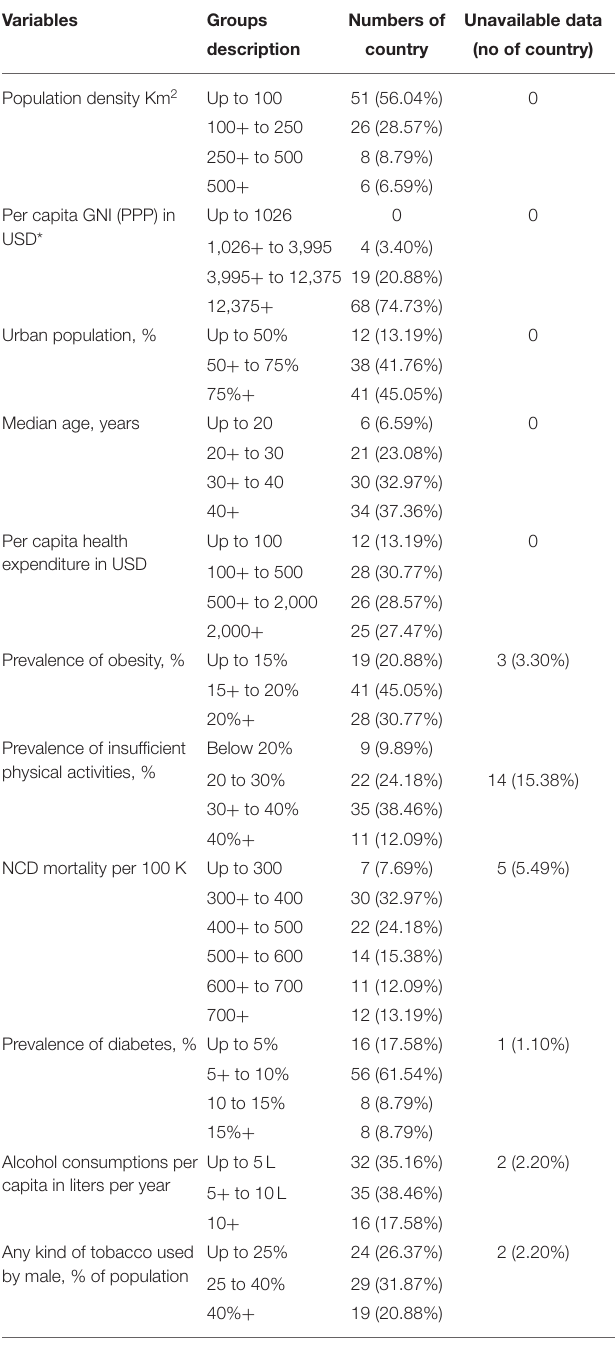
TABLE 1 | Characteristics of grouped independent